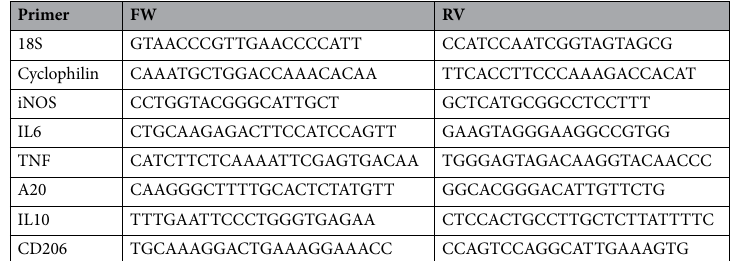
Table 3. Primers for RT-PCR.